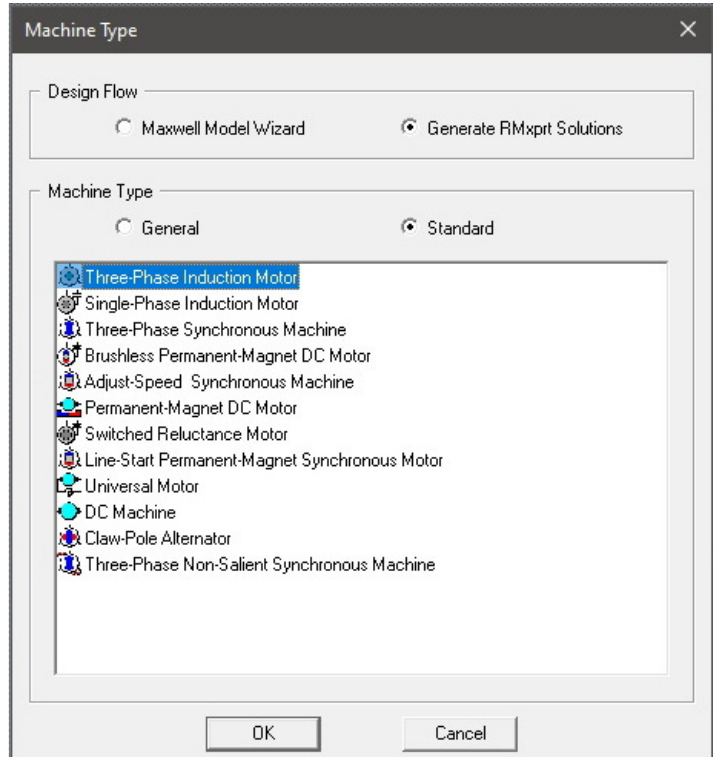
Figure 7. Selecting the type of electric motor.